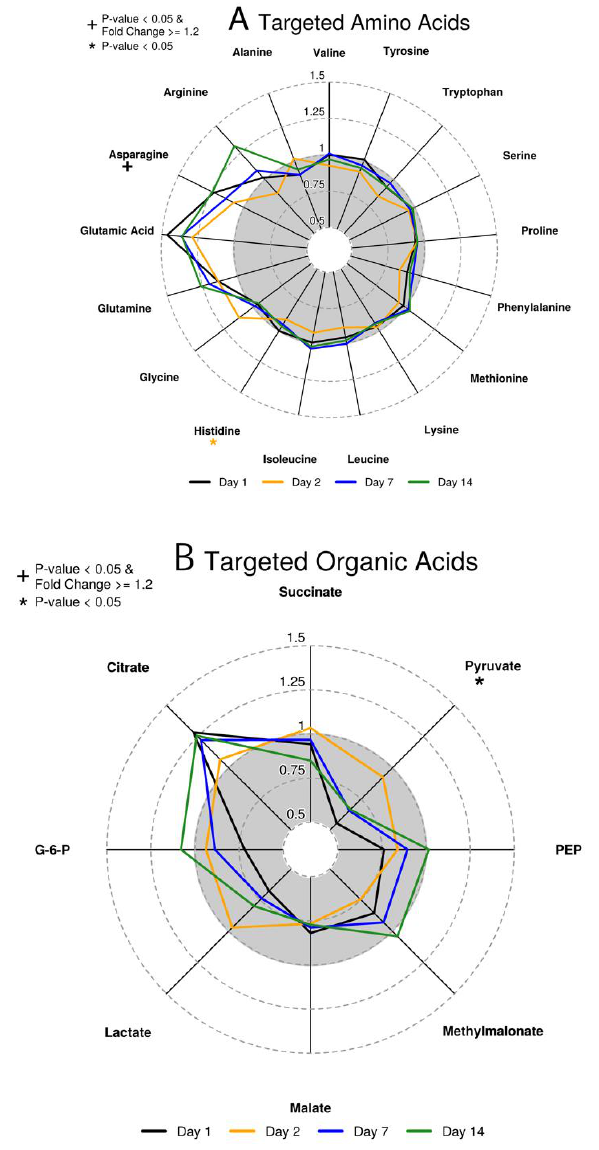
Figure 4. Radar plots summarizing changes in targeted amino and organic acids. ( A ): amino acids; ( B ): organic acids. Each ray represents one targeted metabolite. Each line presents the mean fold change compared to pre-vaccination for a particular post-vaccination day. Asterisks indicate statistically significant up-regulation ( p -value < 0.05), while a plus symbol represents statistical significance ( p -value < 0.05) and a fold change of ≥ 1.2. The grey area marks fold changes below 1 indicating that metabolite abundance was lower than pre-vaccination for the respective metabolite and post-vaccination time